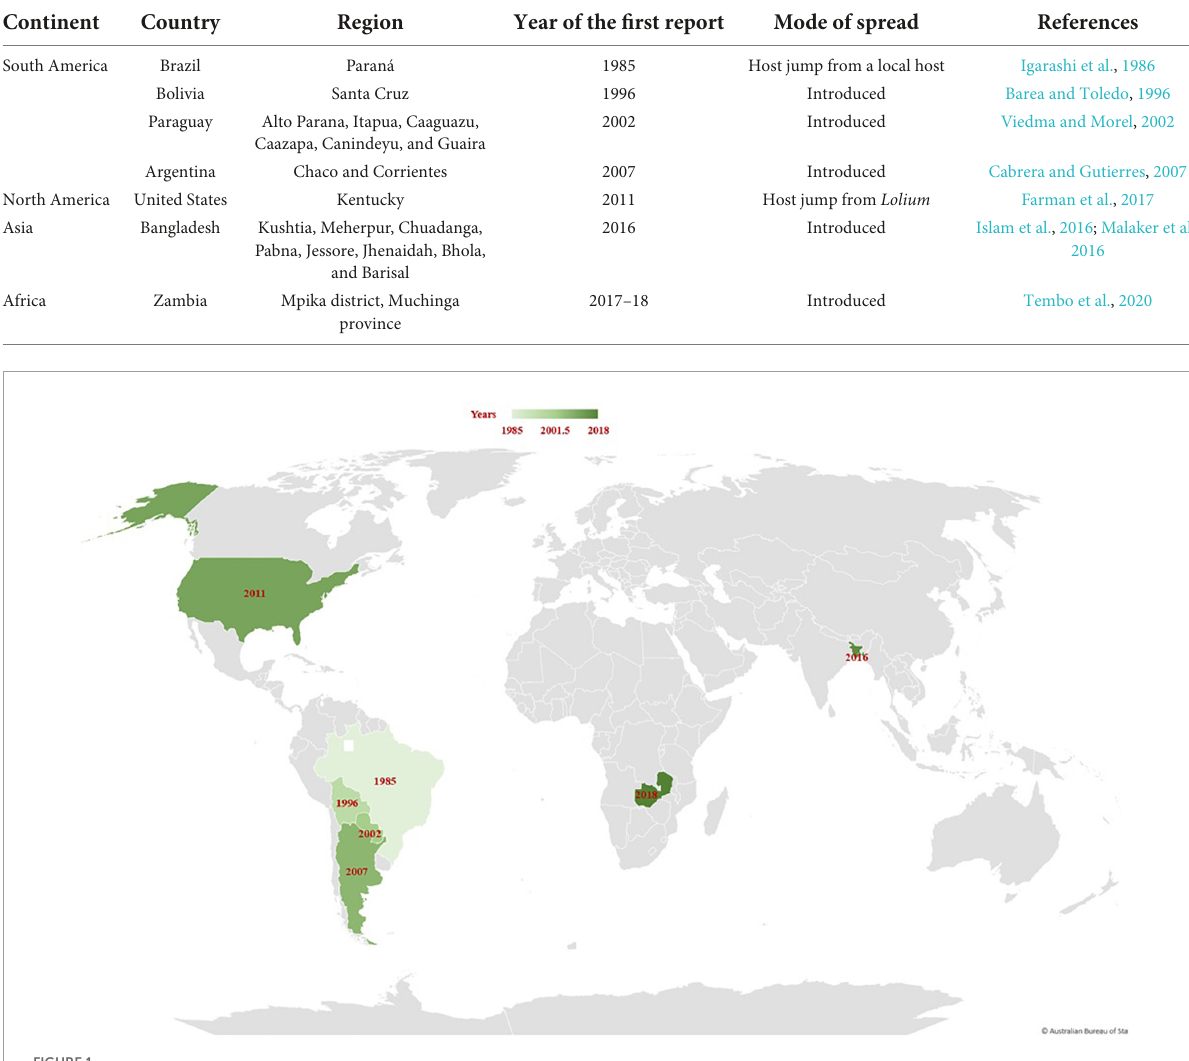
TABLE 1 Emergence and spread of wheat blast in different countries.